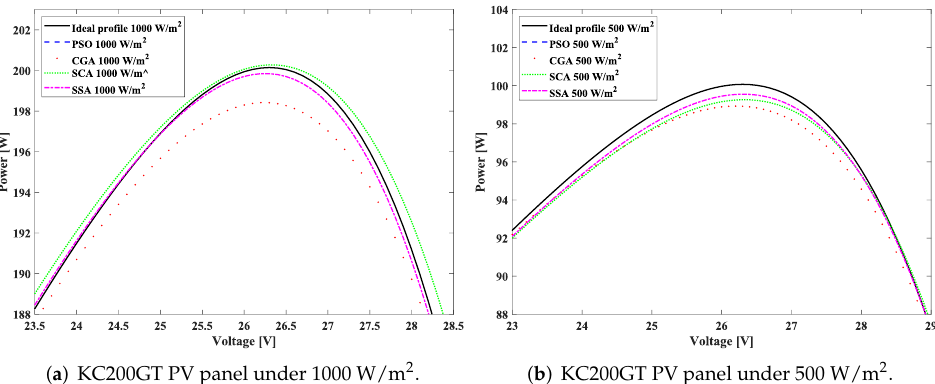
Figure 5. Zoom-ins on the simulation performed with the parameters found for the lowest errors in the KC200GT PV